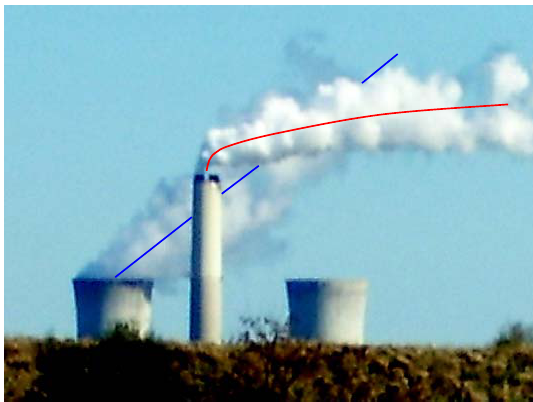
Figure 14. Plumes from an electrical power generating station.